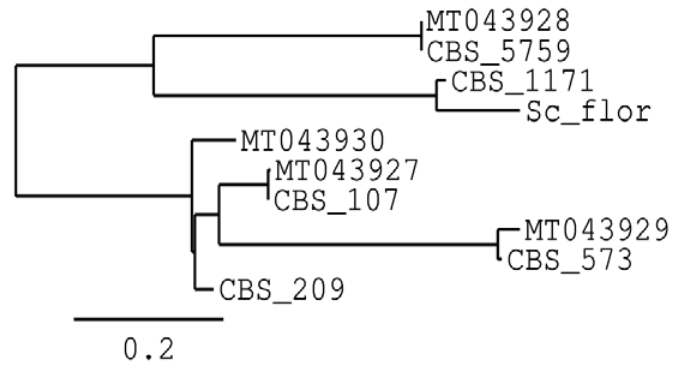
Figure 1. Phylogenetic tree with the non- Saccharomyces isolated in the present work based on their ITS1–ITS4 regions, as well as the sequences of the subsequent type strain and S. cerevisiae flor. MT043927 to MT043930 are the ITS regions for the non- Saccharomyces isolates ( P. membranifaciens , W. anomalus , P. kudriavzevii and P. manshurica , respectively), while Sc flor corresponds to the ITS region of the S. cerevisiae flor used as a control; CBS107, CBS5759, CBS573, CBS209 and CBS1171 are the accession numbers for the ITS region of the type strain for each species, respectively.